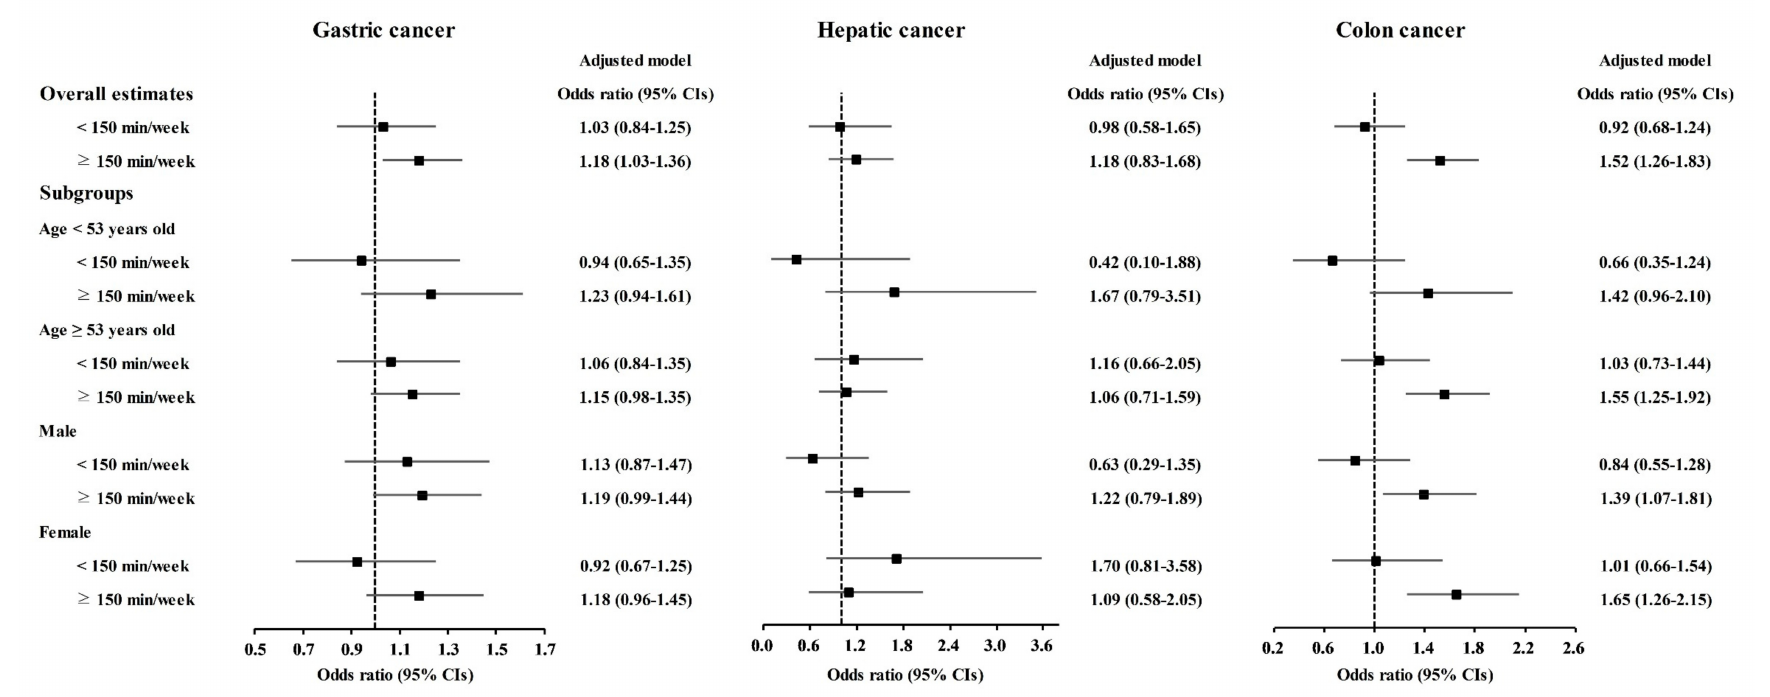
Figure 5. Odds ratios of physical exercise for gastric cancer, hepatic cancer, and colon cancer histories according to age and